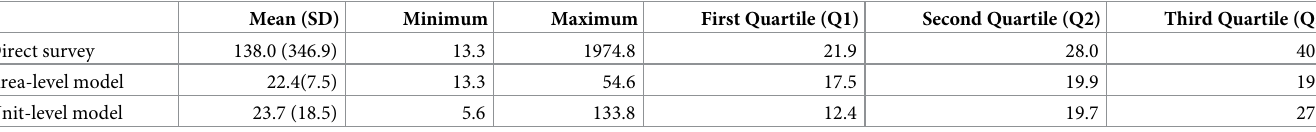
Table 3. Summary of coefficient of variation of HIV prevalence estimates in Uganda �